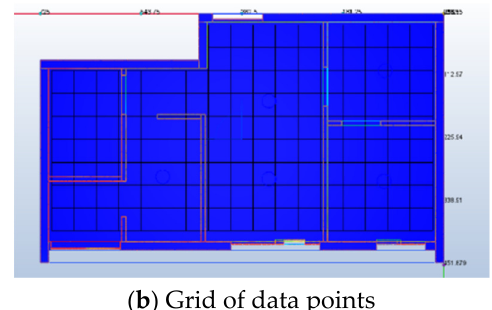
Figure 8. Cutting planes and data points.